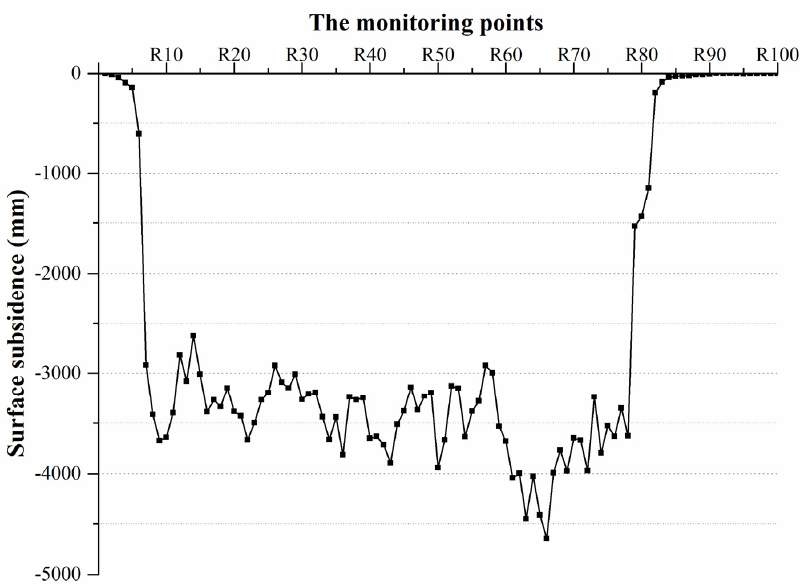
Figure 7. The final subsidence results of the monitoring points on the R line above panel No. 222201 (date: July 15, 2012).